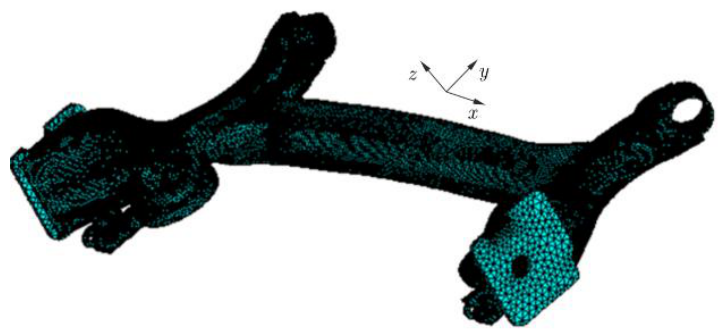
Figure 7. A discrete model of the rear suspension twist beam of the Panda II car. Loads acting on the beam are introduced by the so-called interface points, i.e., points where forces and torques calculated in the MSC.Adams are applied (Figure 8). These points are determined in the ANSYS package and then exported with the discrete beam model to the MSC.Adams package. In the considered model, it is assumed that the interface points are located in places where the suspension beam is joined with other parts of the rear suspension system.